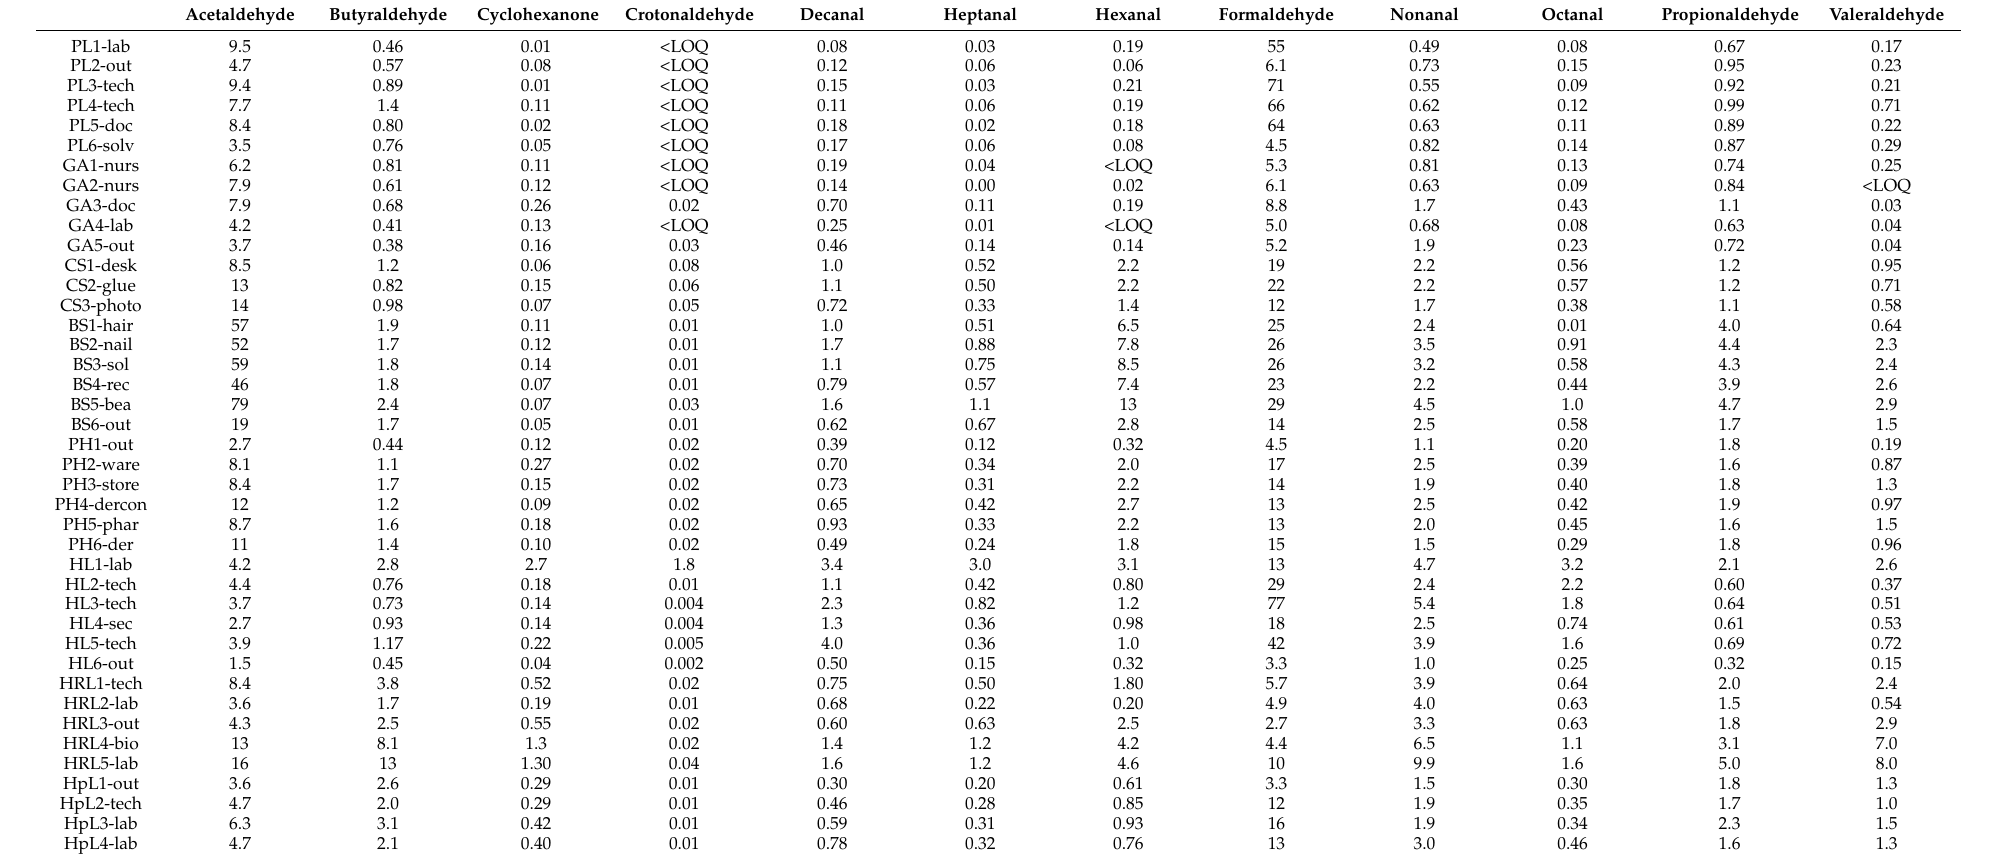
Table 6. Concentration of the 12 Ccs ( µ g m − 3 ) that were determined in the 10 different work